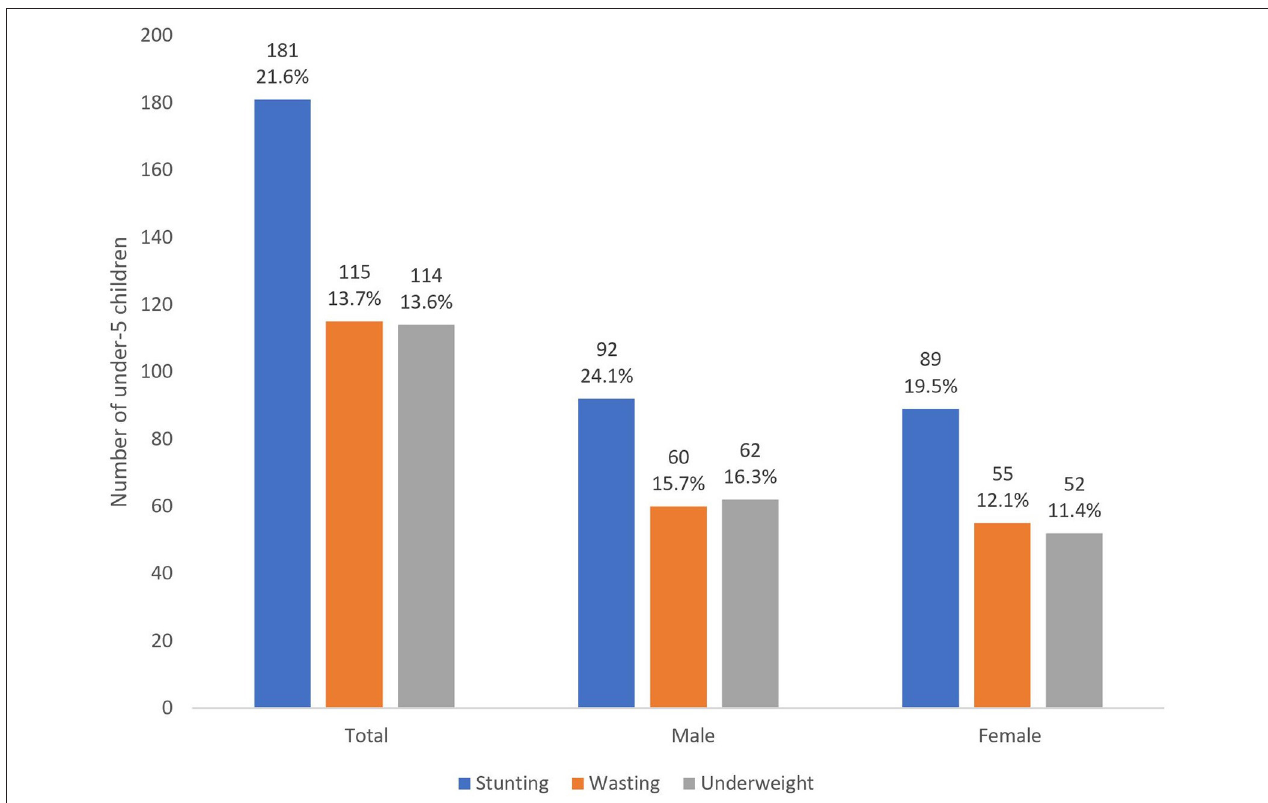
FIGURE 2 | Nutrition status among children aged 0–59 months in Bambao region, July 2021 ( N =